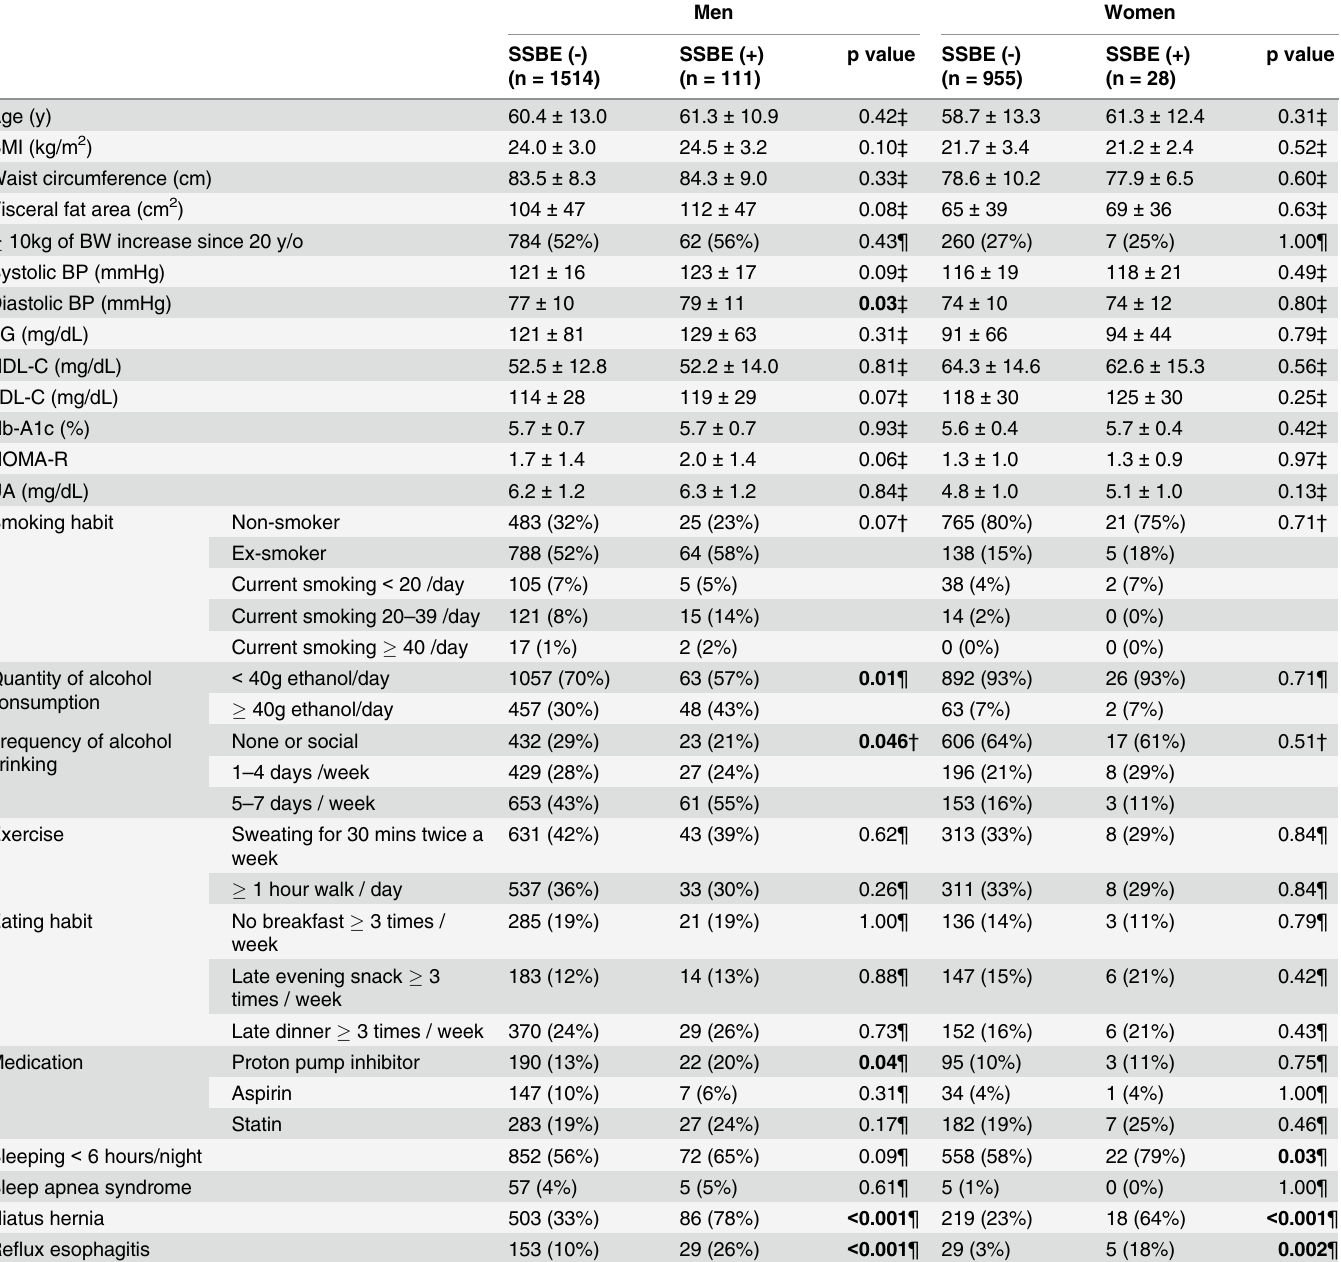
Table 3. Differences between participants with and without short-segment Barrett ’ s